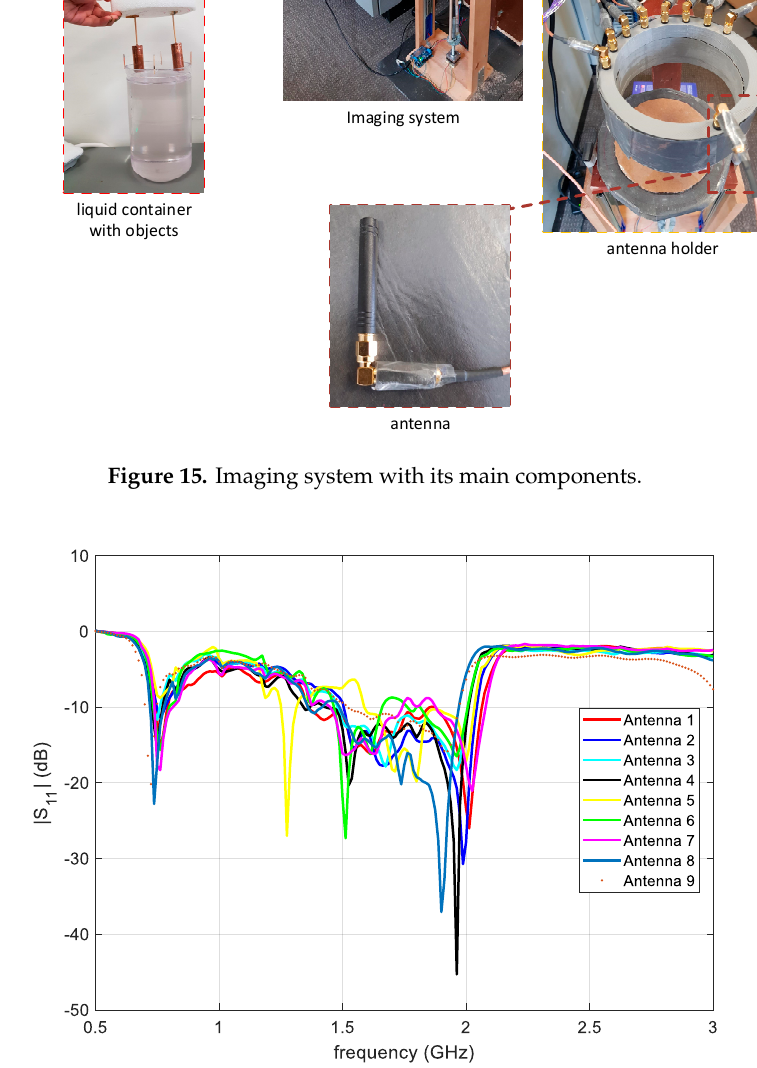
Figure 16. Measured 11 | | S for the nine antennas used as transmitter and receivers.